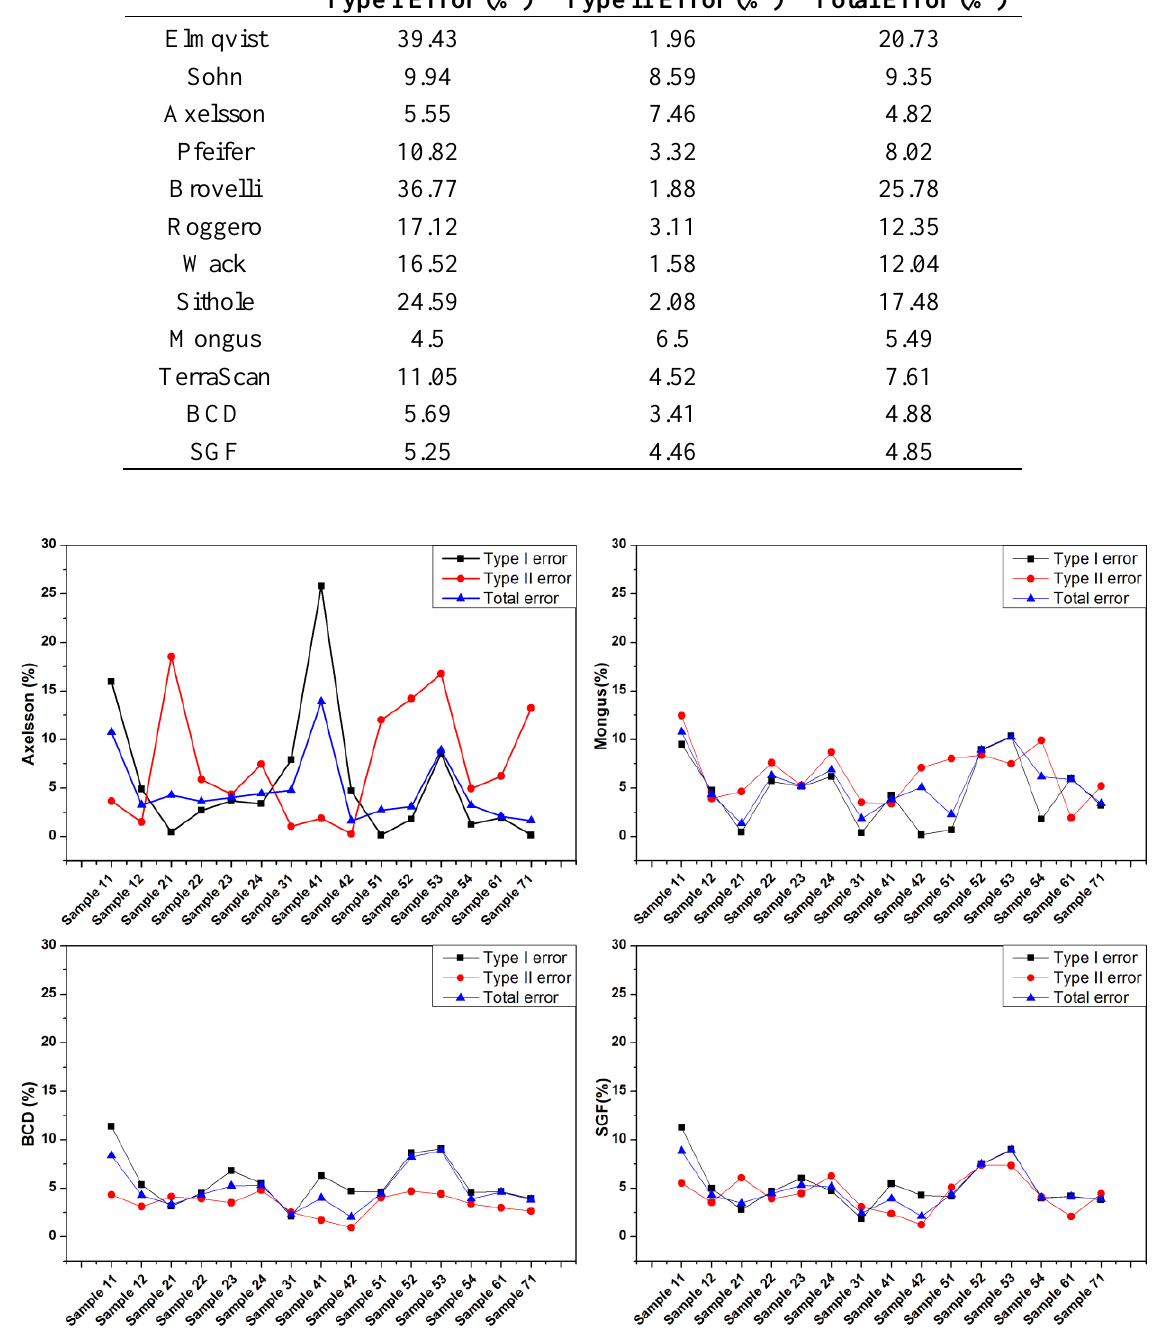
Figure 9. Detailed comparison of Axelsson’s algorithm, parameter-free method (Mongus), BCD, and the proposed SGF algorithm across 15